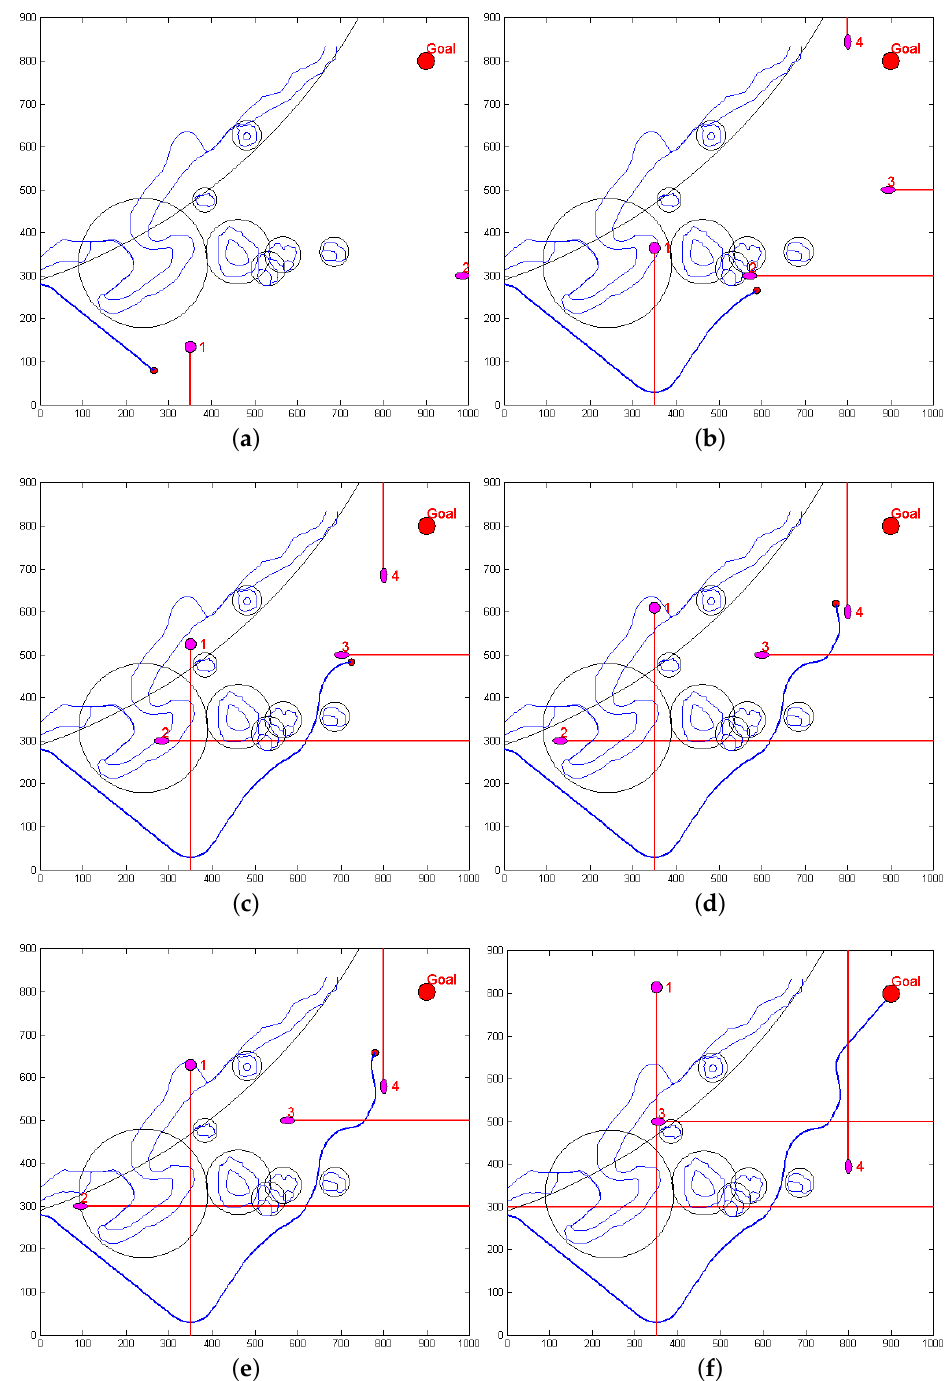
Figure 10. Multiple dynamic obstacle avoidance. ( a ) Encounter obstacle 1; ( b ) Encounter obstacle 2; ( c ) Encounter obstacle 3; ( d ) Encounter obstacle 4; ( e ) Leave obstacle 4; ( f ) Achieve the